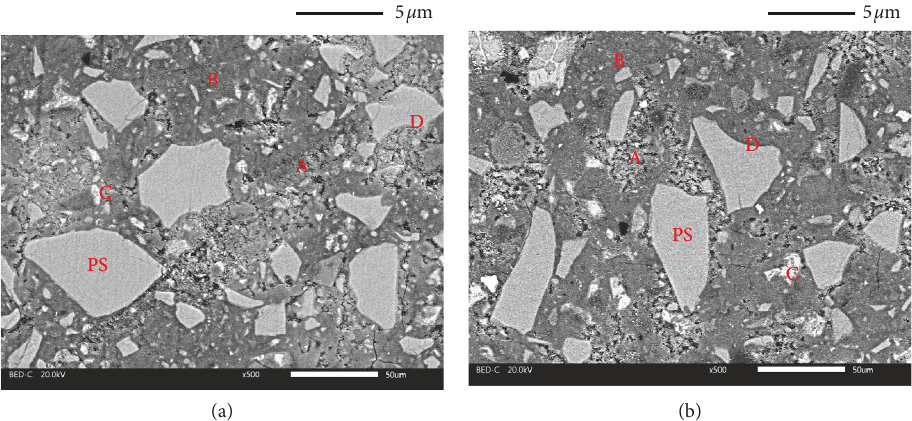
Figure 8: Typical BSE images of specimens hydrated for 28 days. (a) PS40; (b) PS38NC2. PS: ground phosphorous slag; A: porous areas; B: dense areas; C: unhydrated cement grains; D: PS.